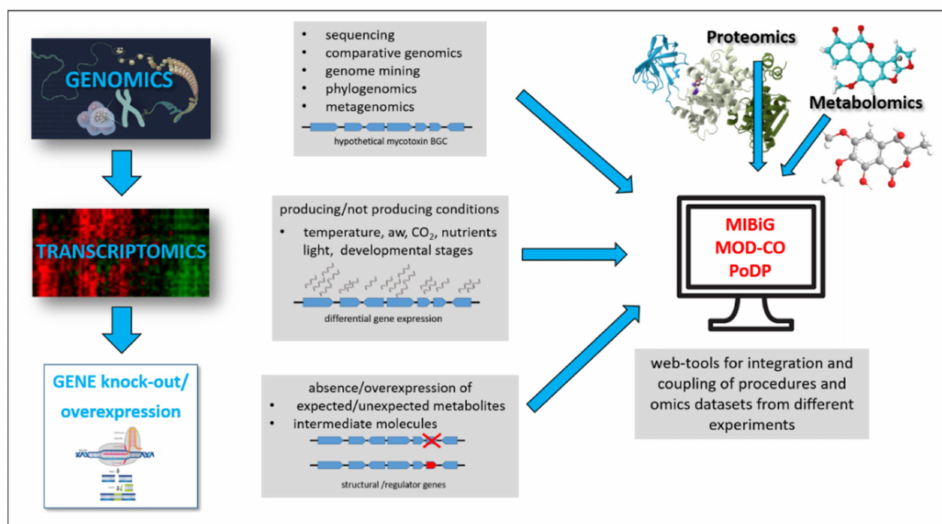
Figure 1. Schematic representation of experimental approaches used to identify and characterise a mycotoxin biosynthesis gene cluster